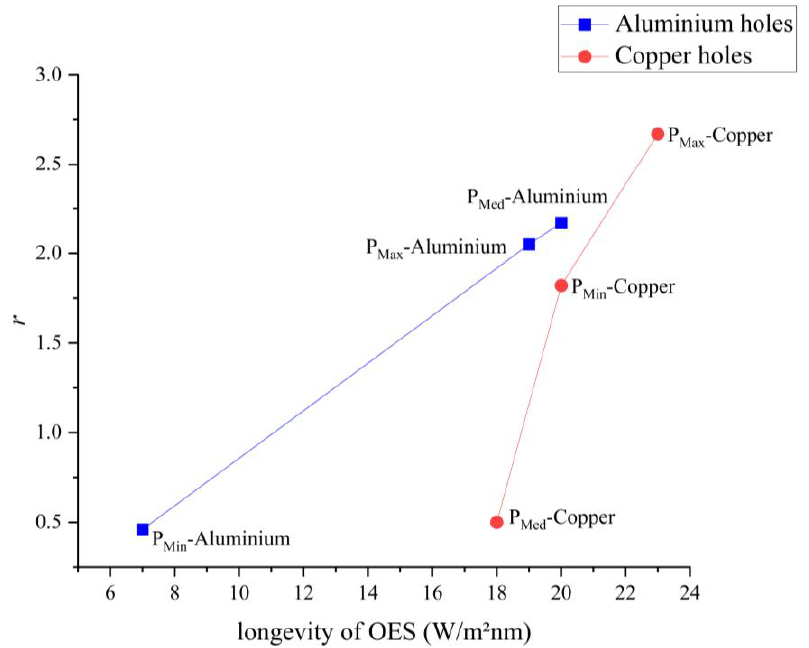
Figure 11. Summary of OES analysis: r factor (depth and width of crater) vs. longevity of λ ≈ 500 nm OES emission.